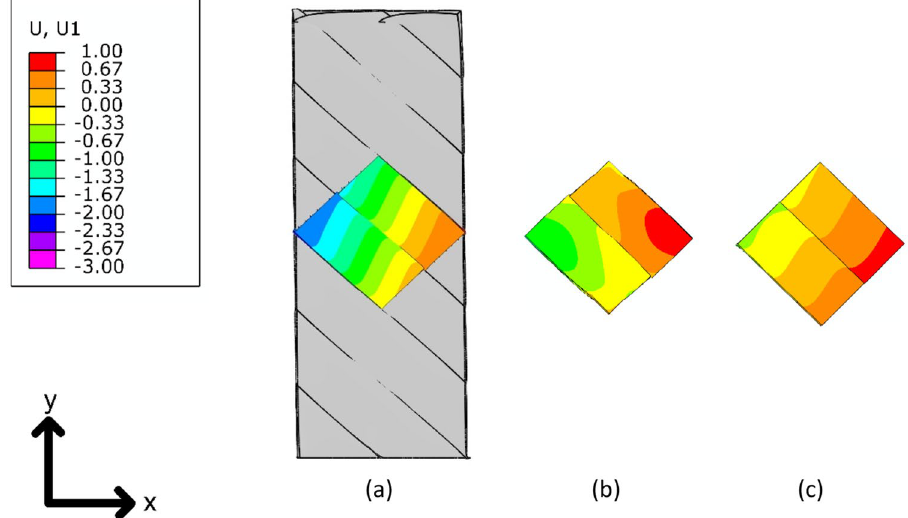
Fig. 5 The relative-to- maximum displacement in x -direction for the CLT panel simulated in diaphragm shear simulation a , diagonal compression simulation b , and pure shear simulation